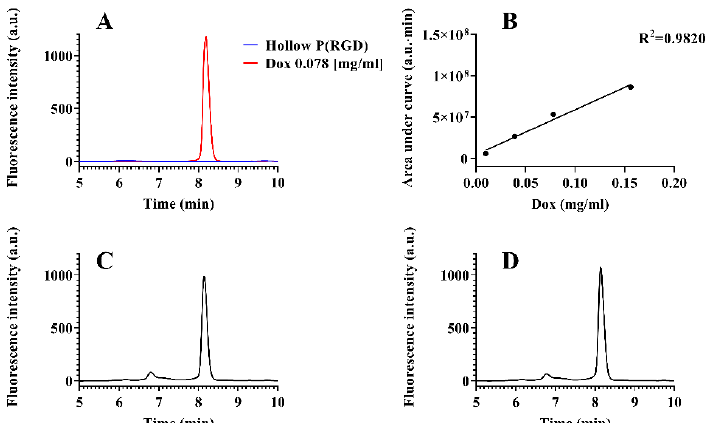
Figure 3. Determination of encapsulated Dox concentration in Dox / P(RGD) NCs. ( A ) Chromatograms of hollow P(RGD) NCs (blue) overlaid with a standard sample of 0.078 mg / mL Dox (Red). Dox was detected after 8.17 min. ( B ) Standard calibration curve of known Dox concentrations. Chromatograms of ( C ) Dox / P(RGD) and ( D ) PEGylated Dox / P(RGD) NCs, respectively. Dox was detected after 8.14 min in both samples as well as a small impurity at 6.8 min.